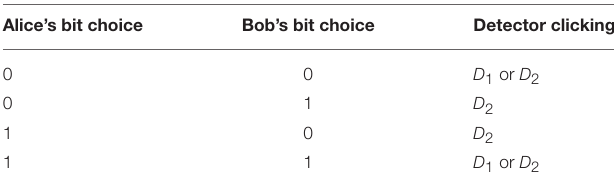
TABLE 1 | Detector action for different bit choices by Alice and Bob for the case of Alice sending in her photon from the top as shown in Figure 1. Alice’s bit choice Bob’s bit choice Detector